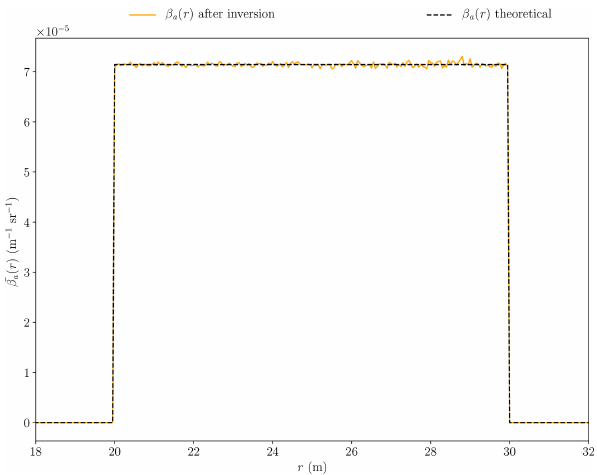
Figure 7. Retrieved β a (r) (orange solid line) for 100 theoretical averaged lidar signals and initial β a (r) (dark dashed line).